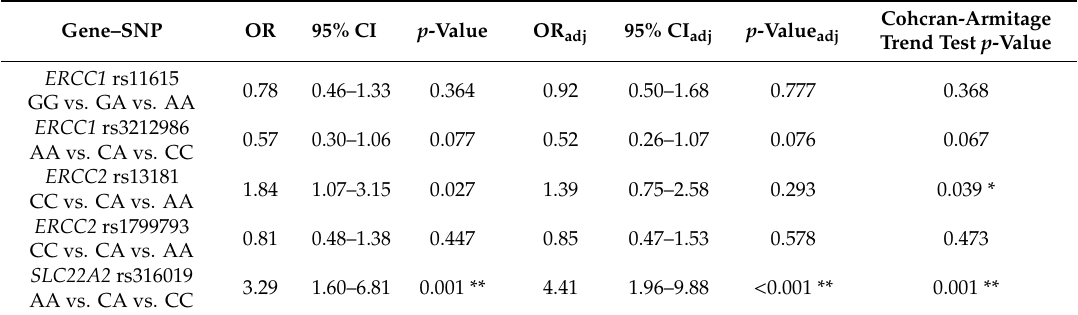
Table 8. Odds ratio of minor allele addition in CTCAE-AKI designation (N = 159) and Cohcran-Armitage trend test result for additive model assumption.